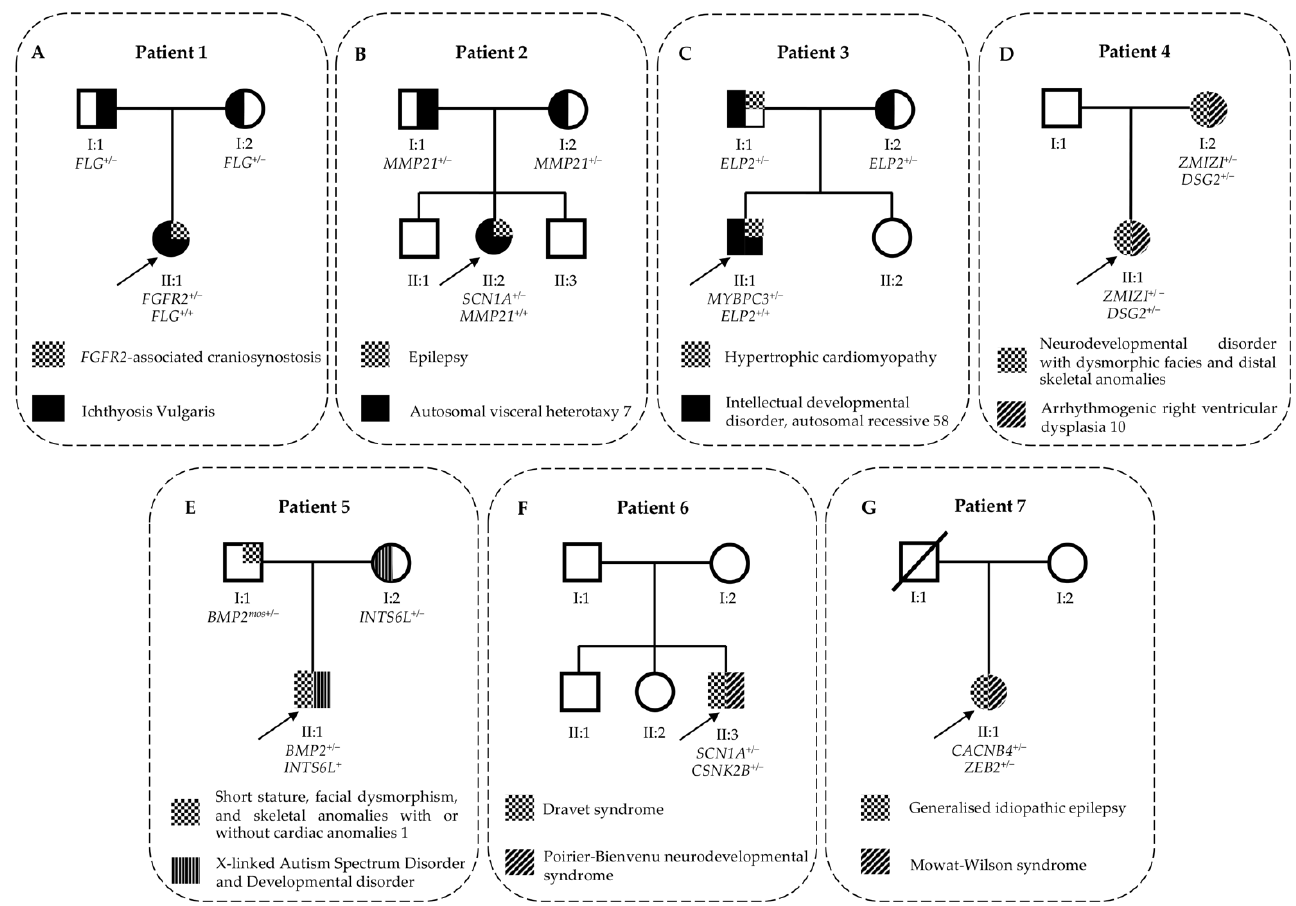
Figure 2. Family pedigrees of patients affected by dual molecular diagnoses. The figure illustrates the main clinical features of each patient and the genes associated with their phenotypes. ( A – G ) indicate each of the seven patients described in this study. Half black filling of father and mother indicates healthy carrier parents. Three-quarters black filling of proband indicates that he/she is affected by an autosomal recessive condition. One-quarter or half chessboard filling of proband or parent indicates that subject is affected by an autosomal dominant disorder. Half diagonal-line filling of proband or parent indicates that subject is affected by another autosomal dominant disorder. Half vertical-line filling of a male proband indicates that he is affected by an X-linked disorder. Half vertical-line filling of a female subject indicates a healthy carrier of an X-linked condition.